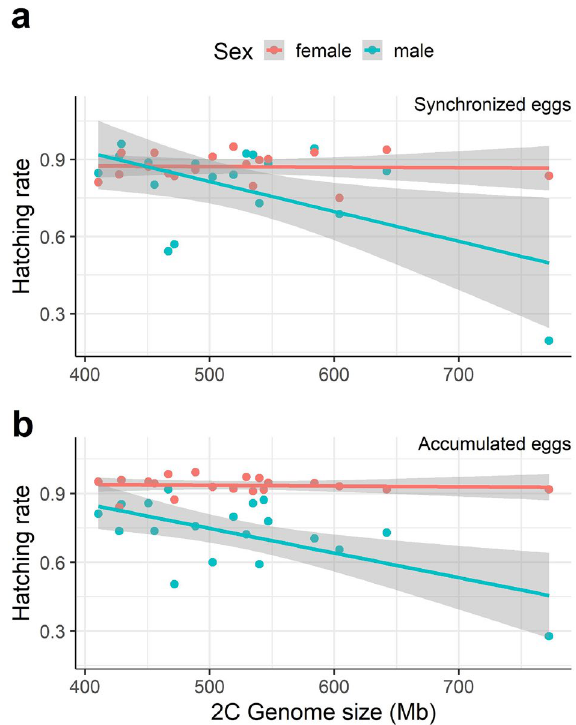
Figure 5. Relationship between hatching rate and genome size in male vs. female eggs. ( a ) In synchronized eggs (i.e., eggs aged < 8 h), hatching rates declined with genome size in males, but not in females, as indicated by a significant negative GS-by-sex interaction in the GLM ( p < 0.001, Table S3). ( b ) In accumulated eggs (i.e., eggs of unknown age, collected from females in a growing culture), hatching rates were lower in males, and the interaction between genome size and sex was significant ( p < 0.001, Table S4). Each colored symbol represents a rotifer clone ( n = 19 clones), shaded areas indicate the 95% confidence intervals. Source data of this figure are provided in Supplementary file